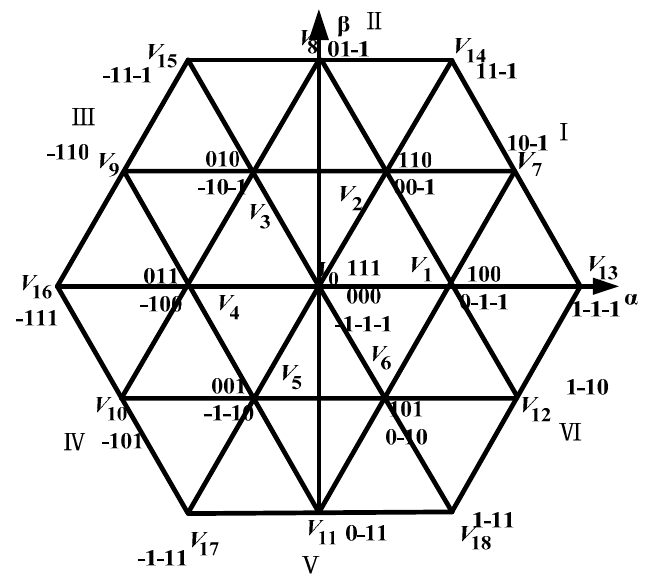
Figure 5. Voltage vectors and switching states of the T-type inverter.